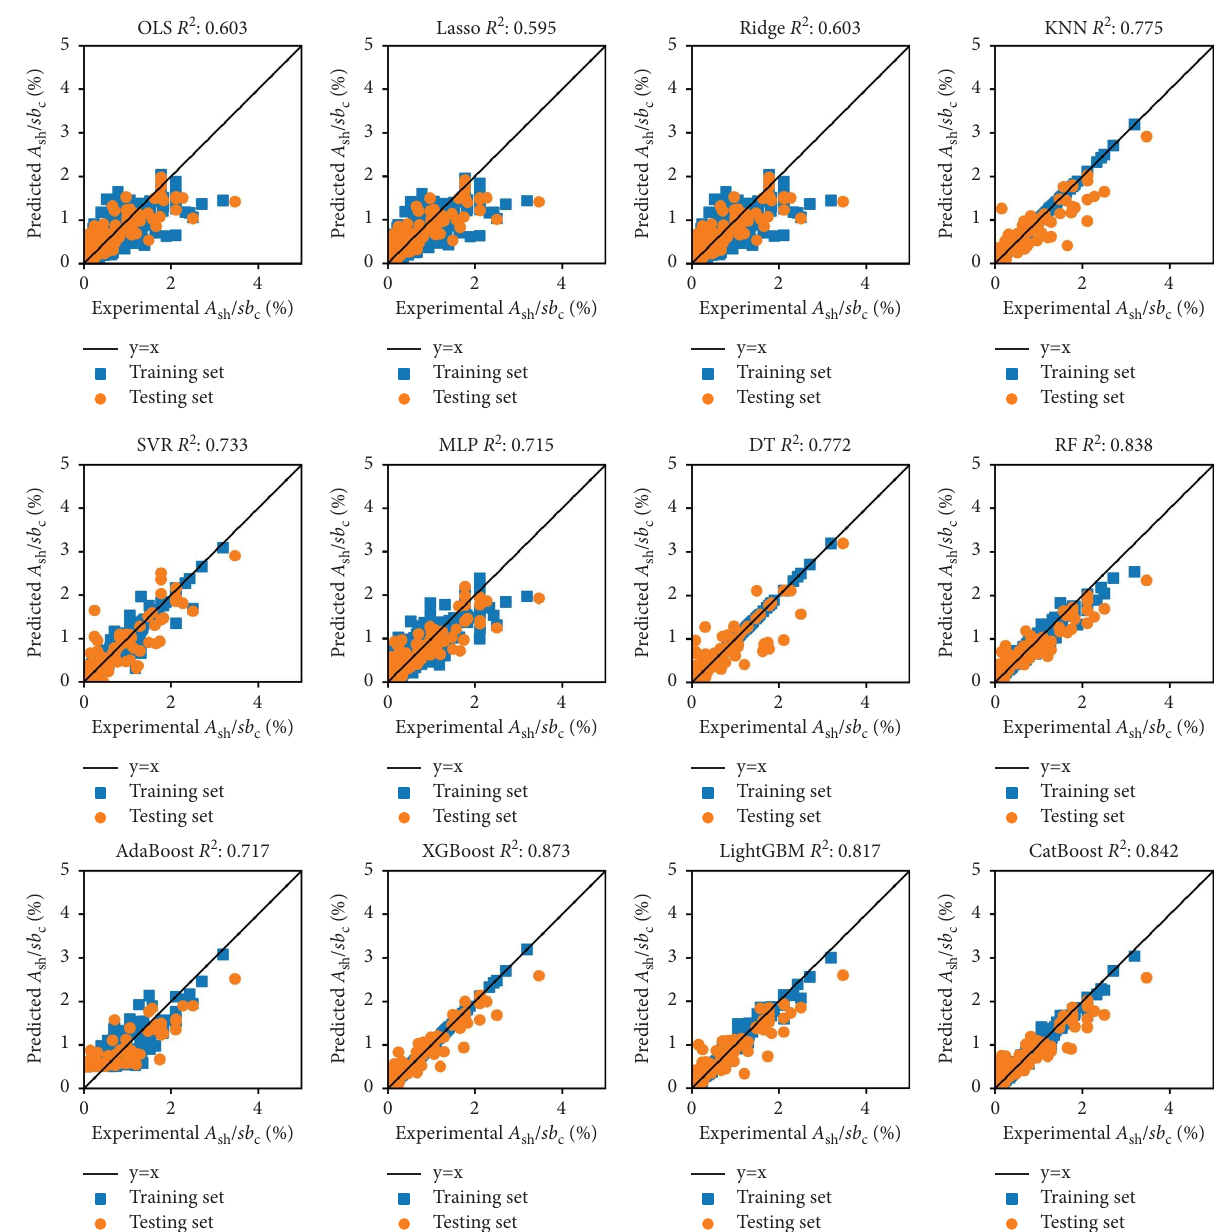
Figure 4: Comparison of predicted and experimental transverse reinforcement